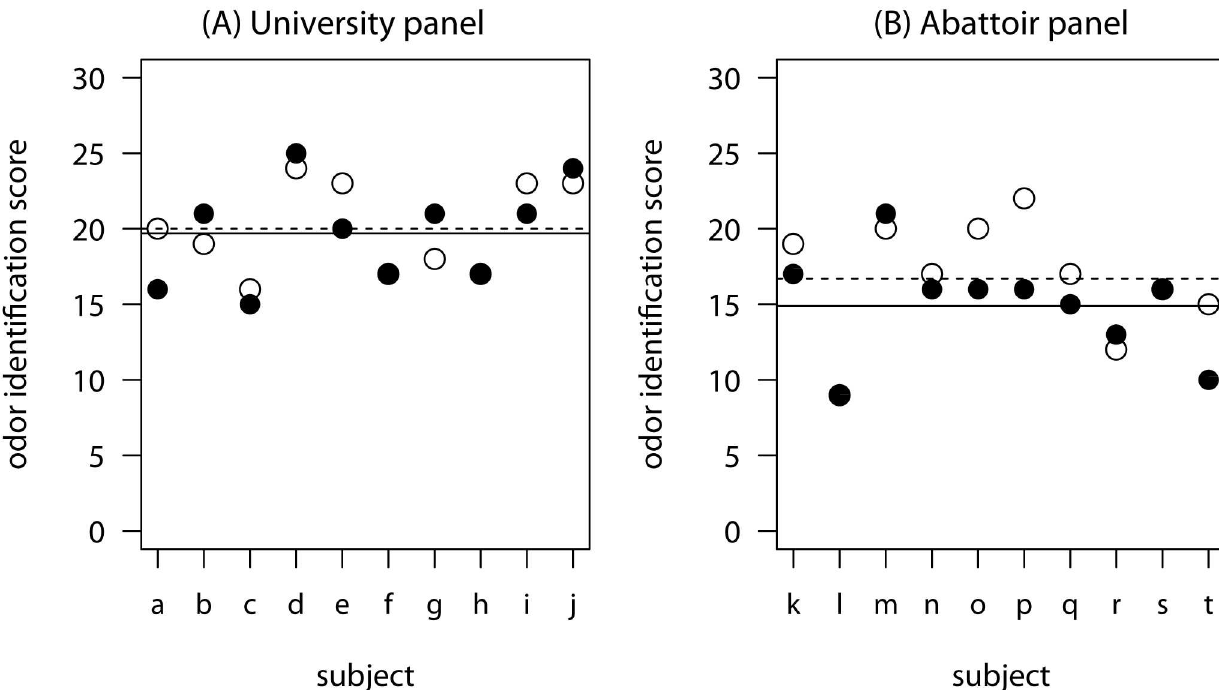
Fig 3. Odor identification task performance of the university panel (left) and the abattoir panel (right) under noise ( ● ) and silent conditions ( (cid:14) ) including the panel averagefor the silent (- - -) and noisy condition ( ── ). The odor identification score rangedbetween0 and 30 with the latter score representinga superiorperformance in identification of variousconcentrations of androstenone and skatole. Abattoir noise (70 dB) was appliedusing headphones.